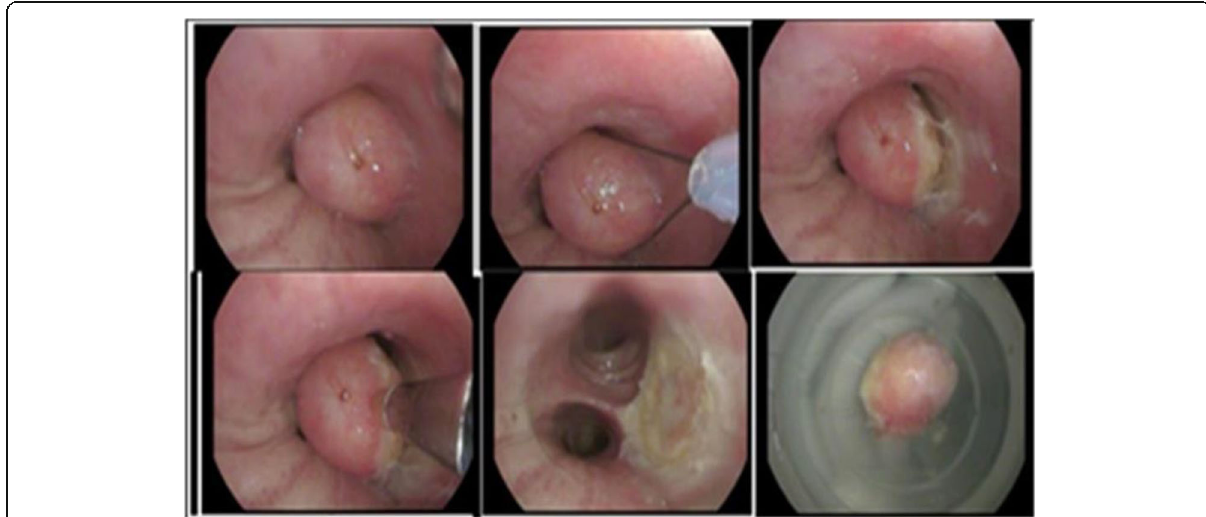
Fig. 1 The inside of the left main bronchus during the tumour removal procedure. A round shape, smooth surface, solid and whitish-pink tumour was removed